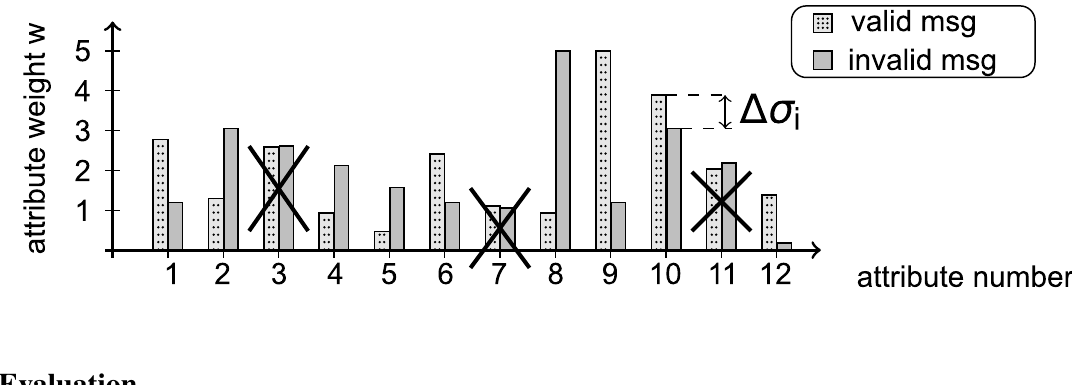
Figure 3. Example of the attribute reduction step to increase